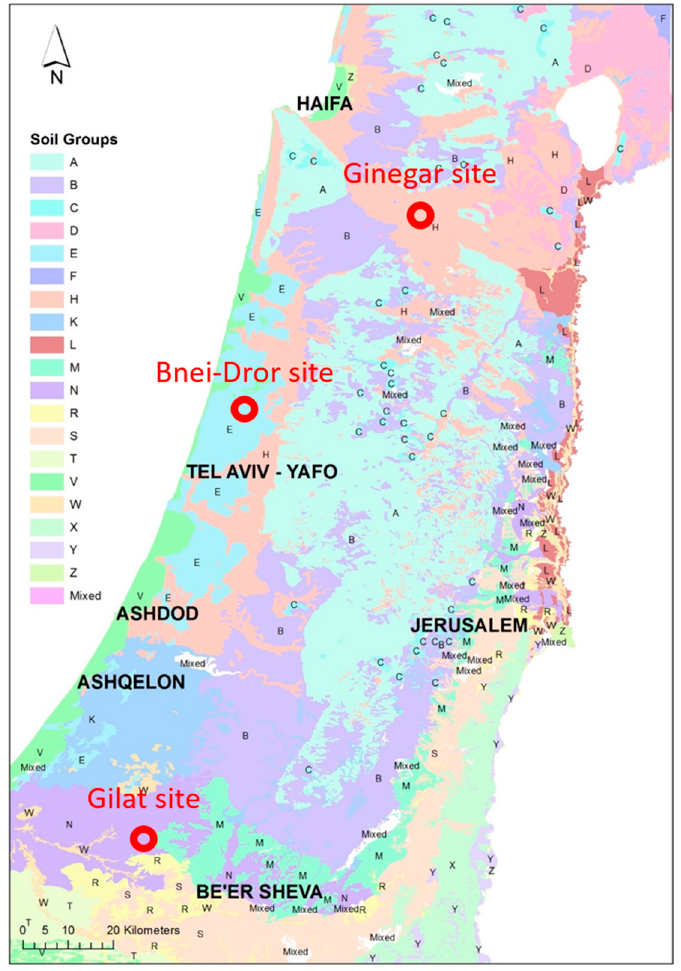
Figure 1. Soil groups map of Israel [12] with the research sites marked with red circles (Gilat, Bnei-Dror, and Ginegar). Soil legend: E—hamra soils, N—loessial arid brown soils, H—grumusol soils.